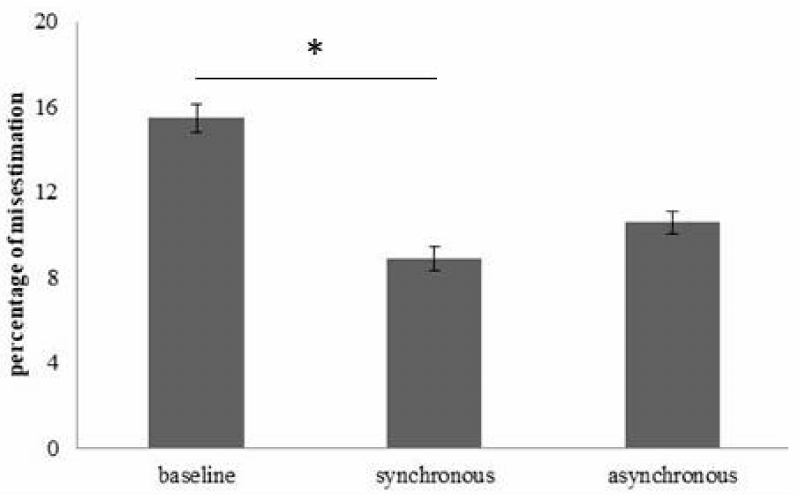
Figure 4. About the circumference estimation of the hips, means of the percentage of misestimation and standard error (bars) were showed for the three experimental condition (baseline, synchronous and asynchronous). * indicates a significant di ff erence according to the Bonferroni-corrected p value of